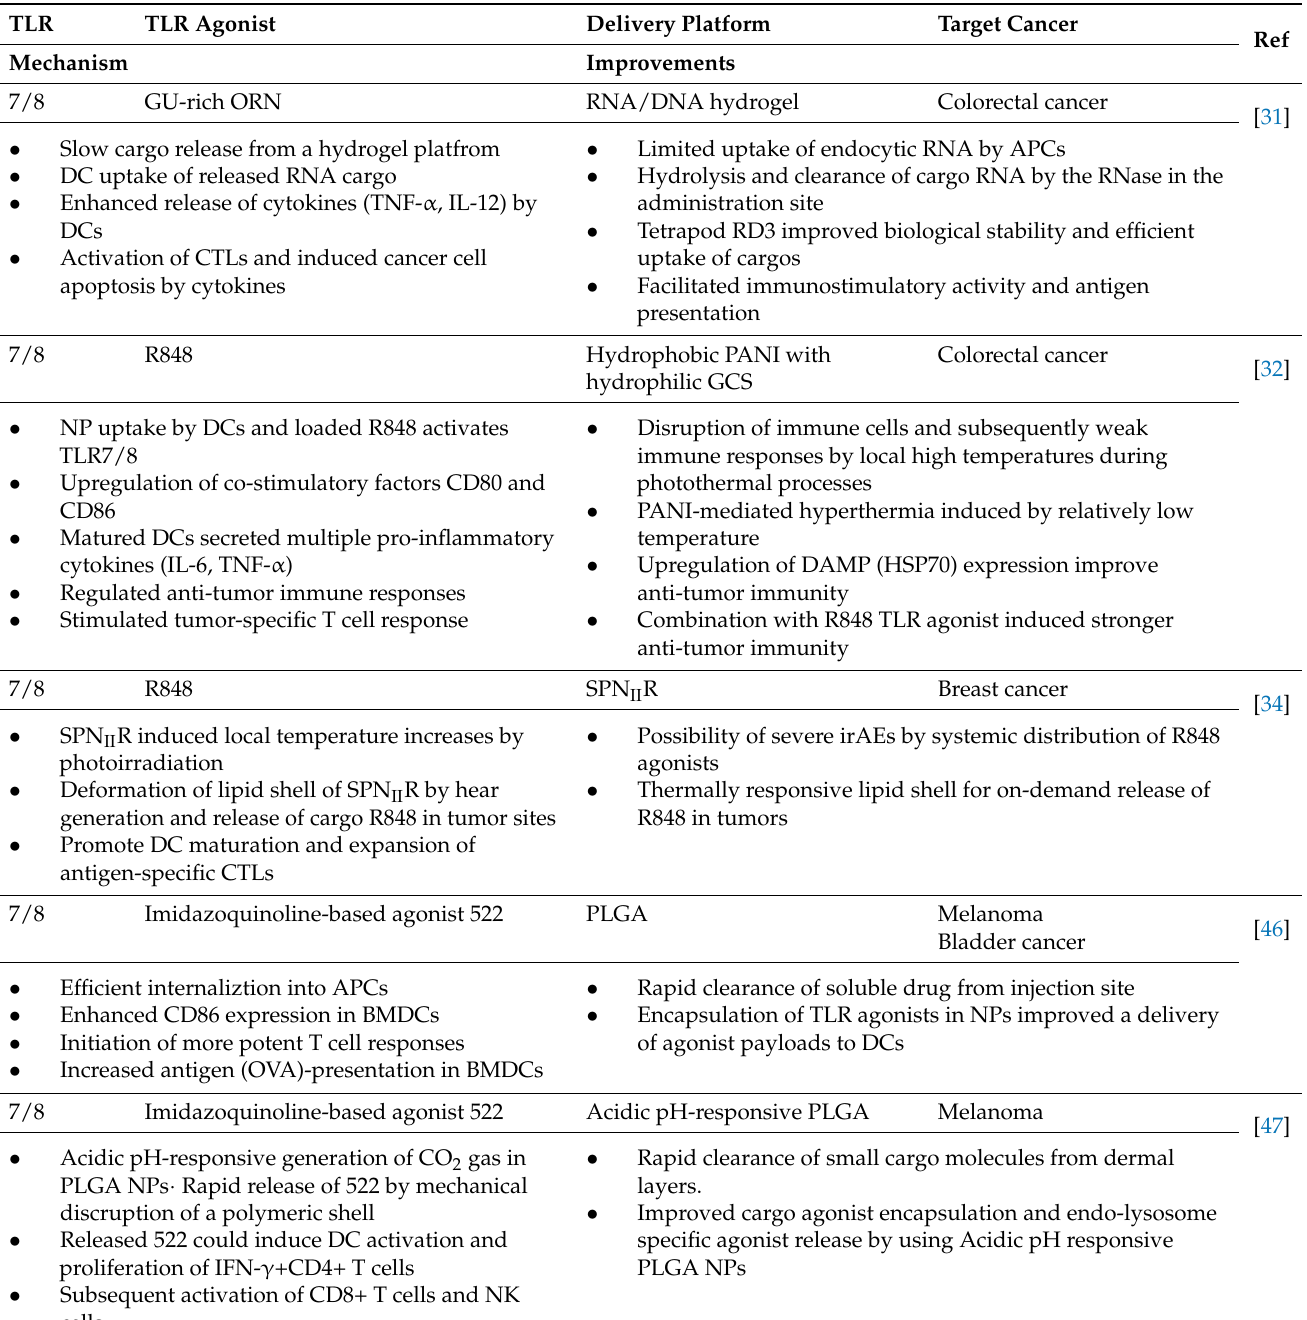
Table 1. Biomaterial-mediated delivery platforms for exogenous single TLR agonist